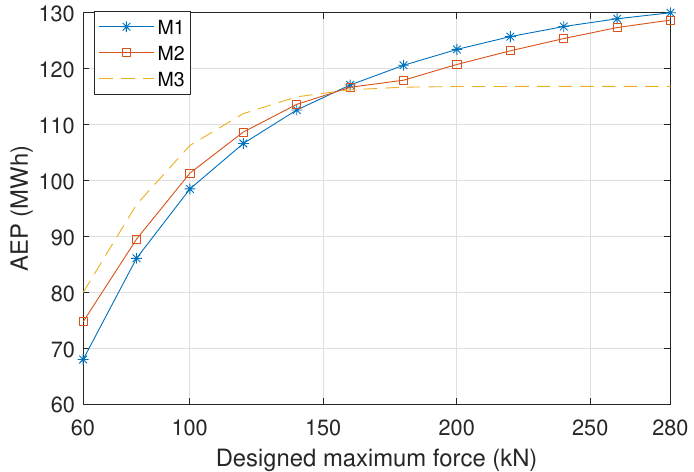
Figure 9. The AEP of the WEC as a function of the designed maximum generator force. “M3” embodies the method 3 for generator